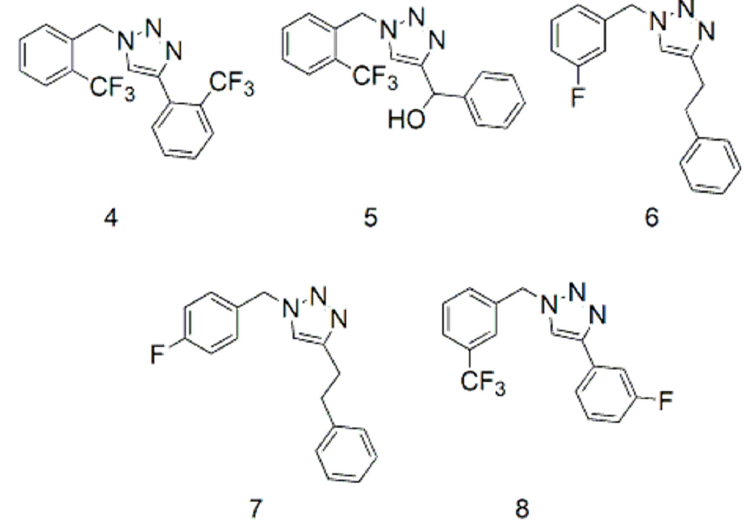
Figure 2. Structures of the fluorinated triazoles.